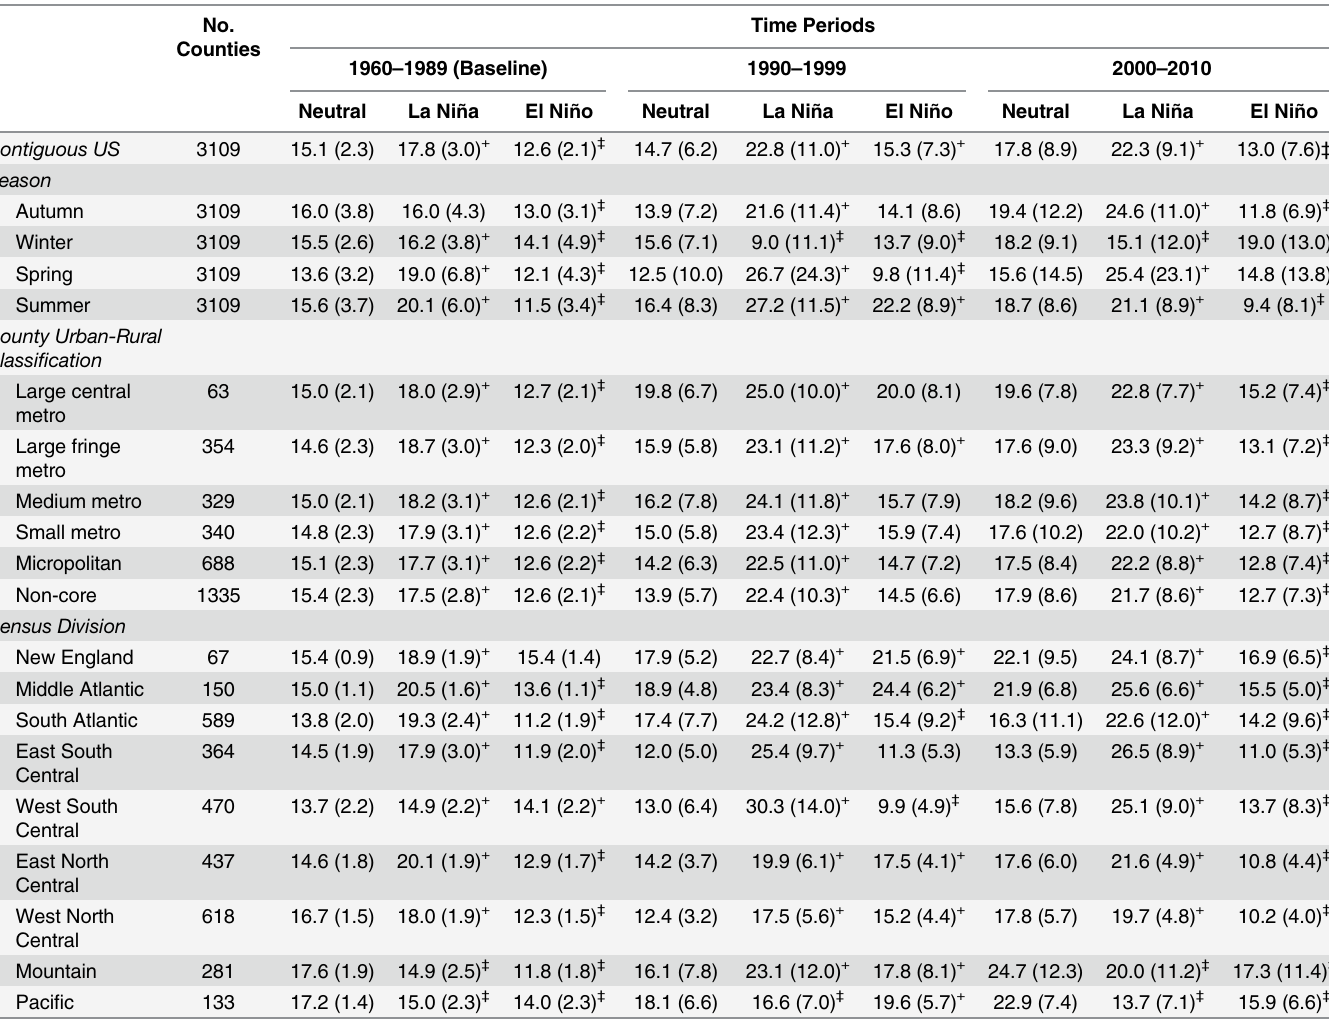
Table 2. County-level annual frequency of extreme heat events (mean (SD)) overall and by season, urbanization and Census Division, across decades and ENSO